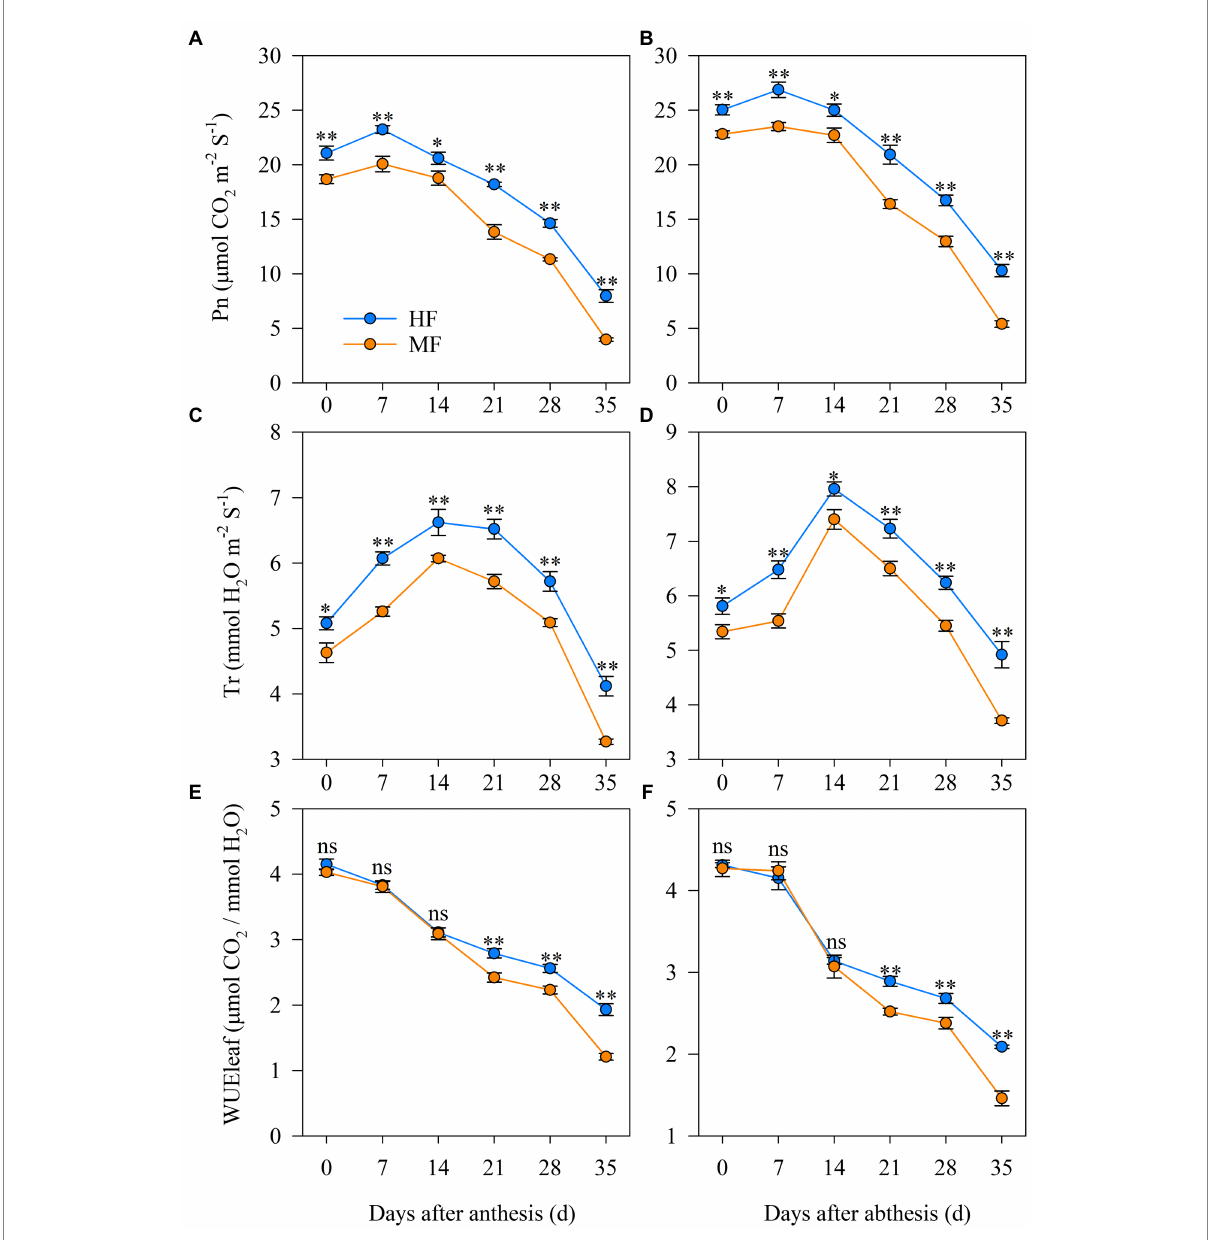
FIGURE 4 Dynamics of the photosynthesis characteristics of flag leaves after anthesis in 2017/18 (A,C,E) and 2018/19 (B,D,F) growing seasons. HF, high soil fertility field and MF, middle soil fertility field. Vertical bars represent the SD of the means. ns, p > 0.05; * p < 0.05 and ** p <